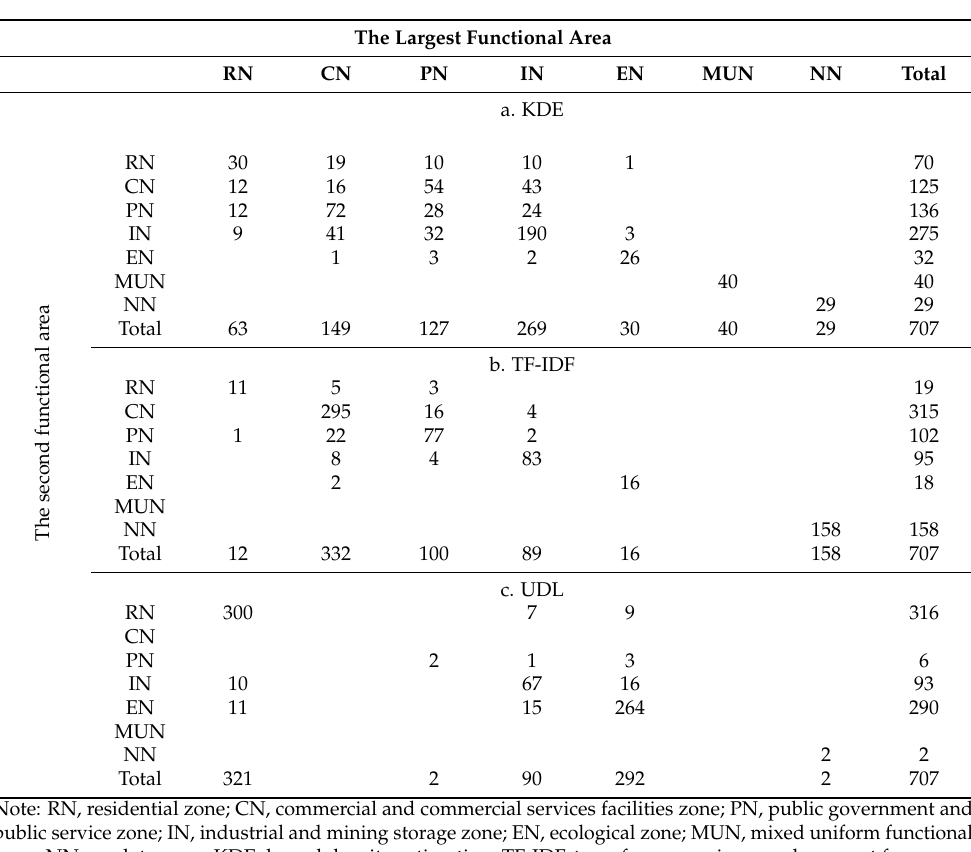
Table 2. Confusion matrix of functional zones where diagonal number is the number of single functional zones, and the other number is the mixed functional zones.